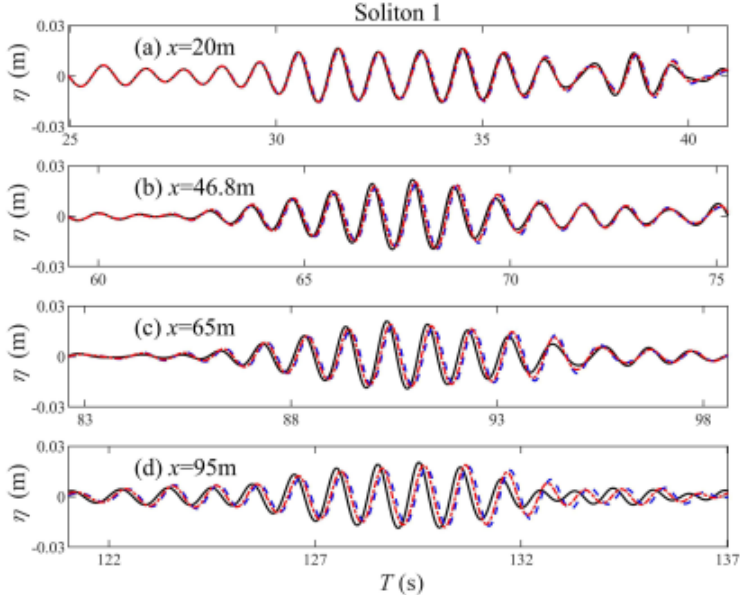
Figure 7. Comparison of Soliton 1 between different nonlinear orders. The blue dashed lines correspond to the simulation with only linear effects ( M = 1). The red dashed dot lines correspond to the simulation with second harmonic effects ( M = 2). The black solid lines correspond to almost fully nonlinear simulations ( M = 6).